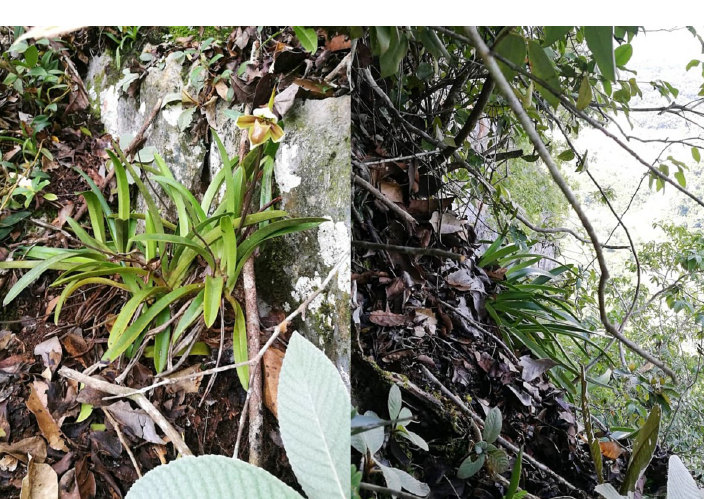
Fig 3. P . exul growing on the cliff of a limestone forest. Photos by Muhamad Faizal Md Azmi.